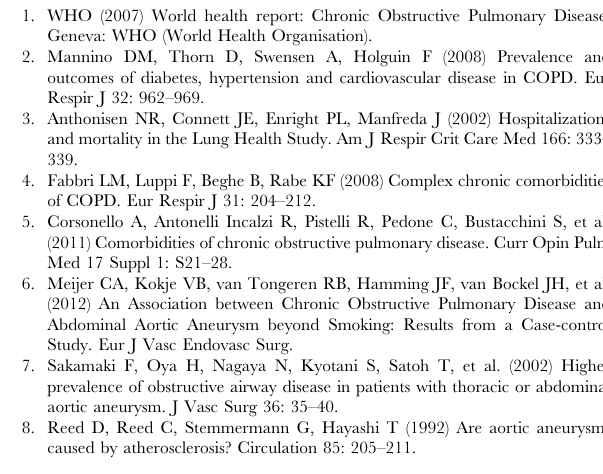
Figure S3 LPS infection induces infiltration of inflam- matory cells in the alveolar compartments. Quantification